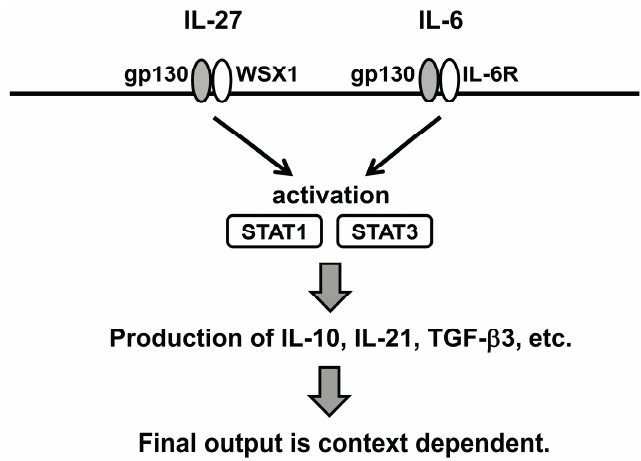
Figure 2. IL-27 and IL-6 can induce common signal transduction pathway in T cell. Output, whether pro- or anti-inflammatory phenotype is granted, may be context